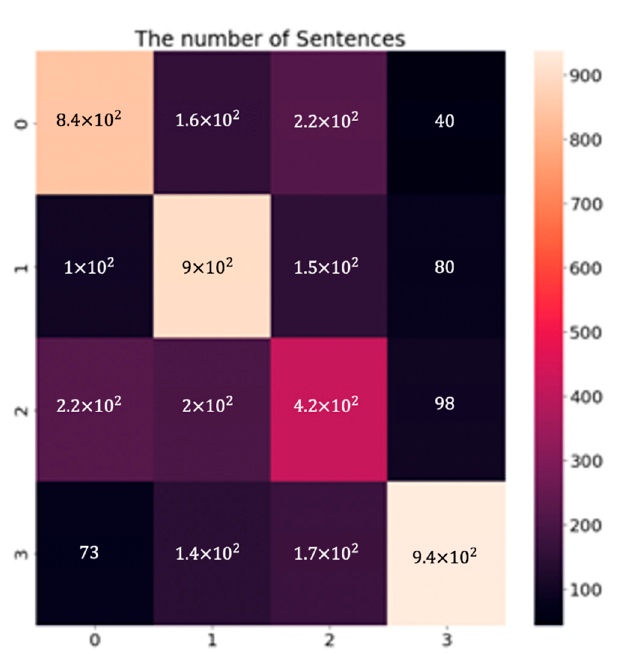
Figure 9. The confusion matrix of the GRU network evaluation result combined datasets with four labels, 0 (Anger), 1 (Sadness), 2 (Neutral), and 3 (Happiness).